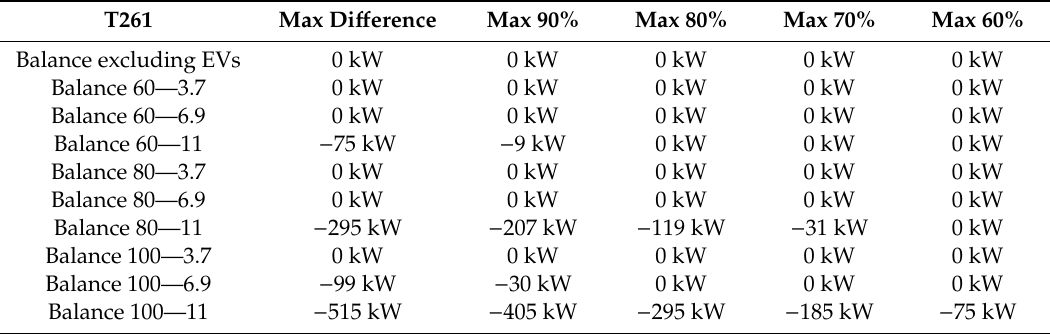
Table 9. Replacement of electric heating by district heating for transformer T261—constant charging.